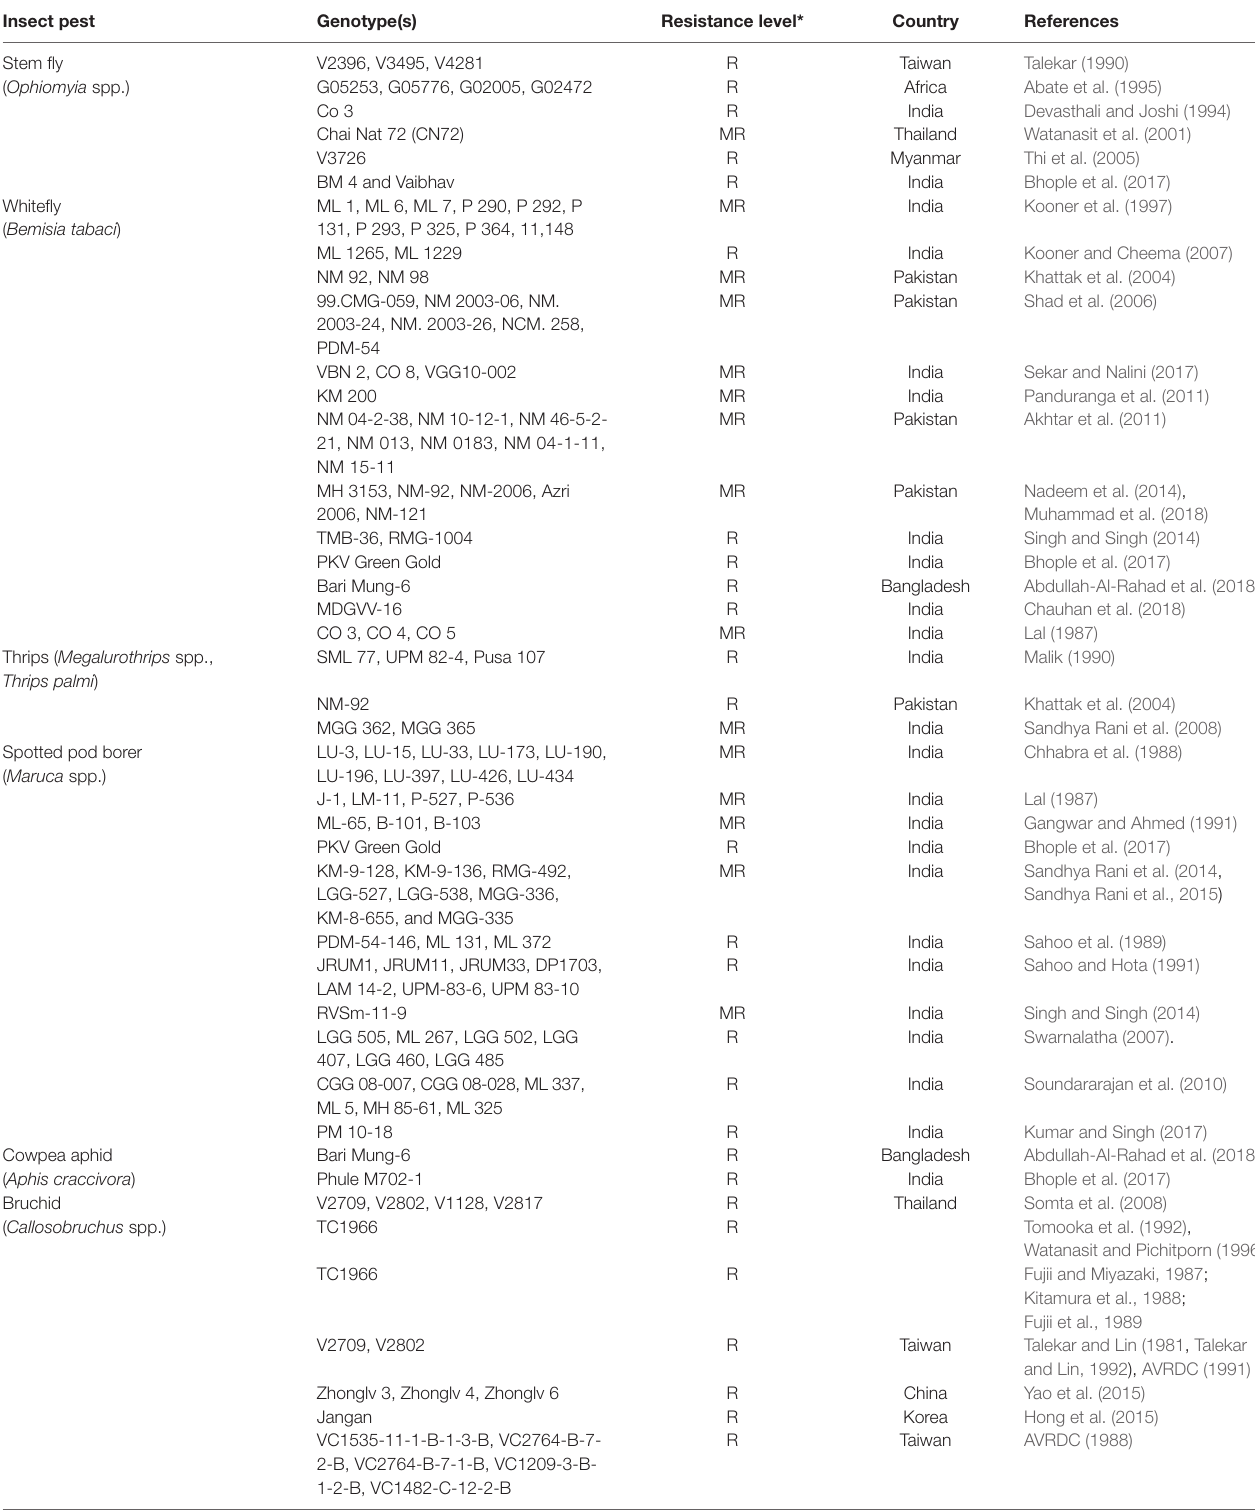
TABLE 3 | Resistant sources of mungbean against insect